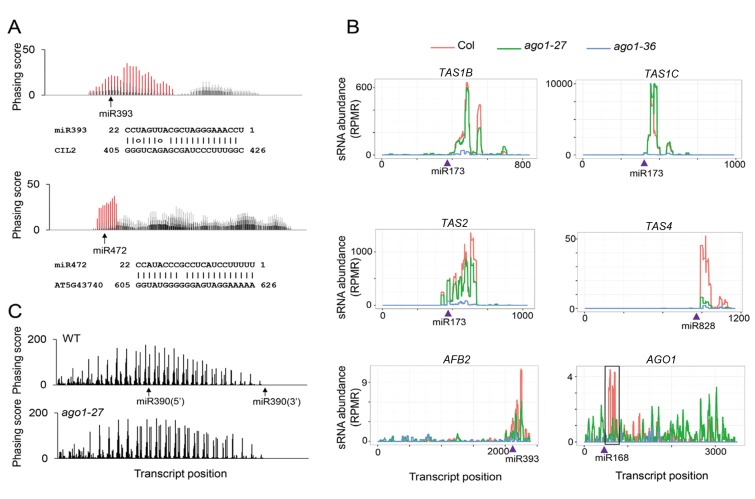
The effect of ago1-27 on ta-siRNAs/phasiRNAs.(A) Two newly identified phasiRNA loci, CIL2 and an NBS-LRR gene, triggered by miR393 and miR472, respectively. The phasing scores along the two transcripts are shown, with phasiRNA producing positions marked in red. The pairing between the miRNAs and the target sites is presented below the plots. (B) ta-siRNA/phasiRNA levels from loci targeted by various AGO1-bound miRNA triggers in WT (red), ago1-27 (green) and ago1-36 (blue). ta-siRNAs/phasiRNAs were nearly eliminated in ago1-36 at all loci and were reduced in ago1-27 at most loci. TAS1C is the only example showing an increase in ta-siRNAs among 23 non-TAS3 phasiRNA-generating loci in ago1-27 (see Supplementary file 4). (C) The phasing of AGO7-dependent ta-siRNAs from the TAS3A locus was not affected in ago1-27.